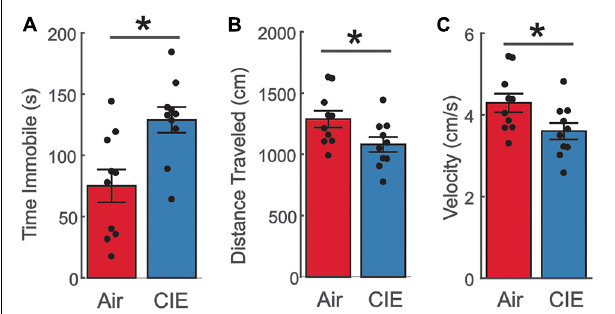
FIGURE 4 | Female CIE-treated rats show a depressive-like phenotype on the FST. (A) CIE-treated female rats ( n = 10) spent more time immobile, (B) traveled a shorter distance, and (C) had a slower moving velocity than their Air control ( n = 10) counterparts. All data are expressed as the mean ± SEM * p <